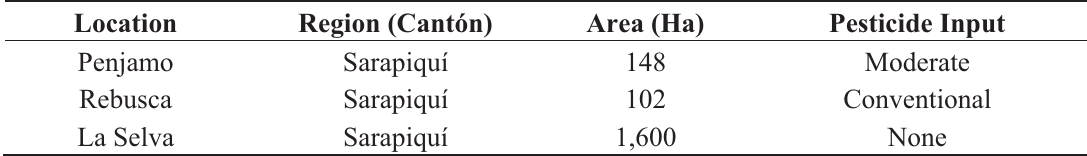
Table 1. Locations used for caterpillar collection. The main measurable difference between the sites were that conventional plantations used at least 5 applications per year of 6–8 kg ha (cid:2)1 Terbufos (a nematicide), the moderate plantations used 1 application per year of 4–5 kg ha (cid:2)1 Terbufos, and no pesticide inputs were applied at La Selva (See [5–7] for complete list of pesticides